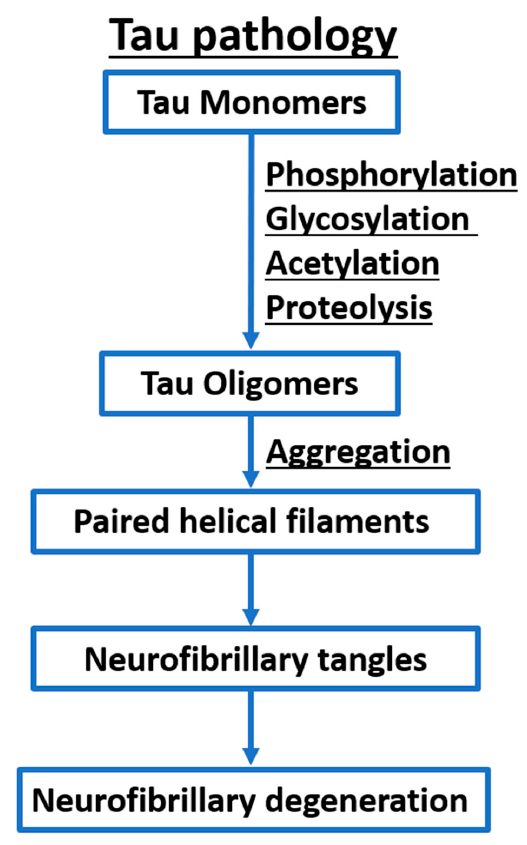
Figure 7. A simplified illustration of Tau pathology.